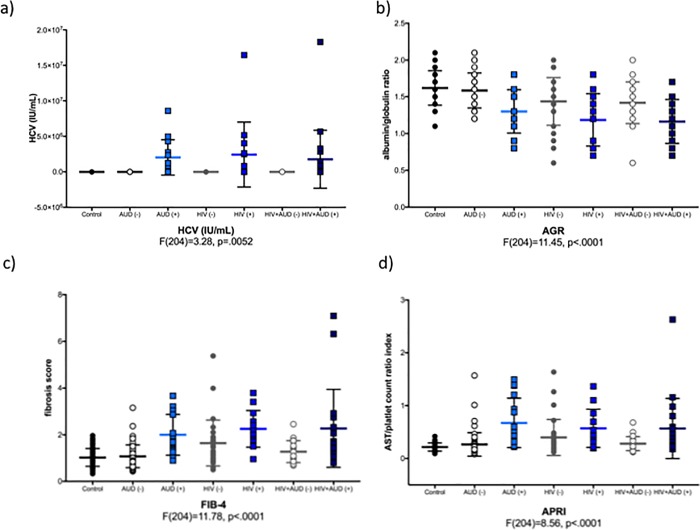
Scatter plots of a) HCV viral load, b) albumin/globulin ratio (AGR), c) fibrosis score (FIB-4), and d) AST/platelet count ratio index (APRI) in the 4 study groups by HCV status (see legend to Fig 2 for details).